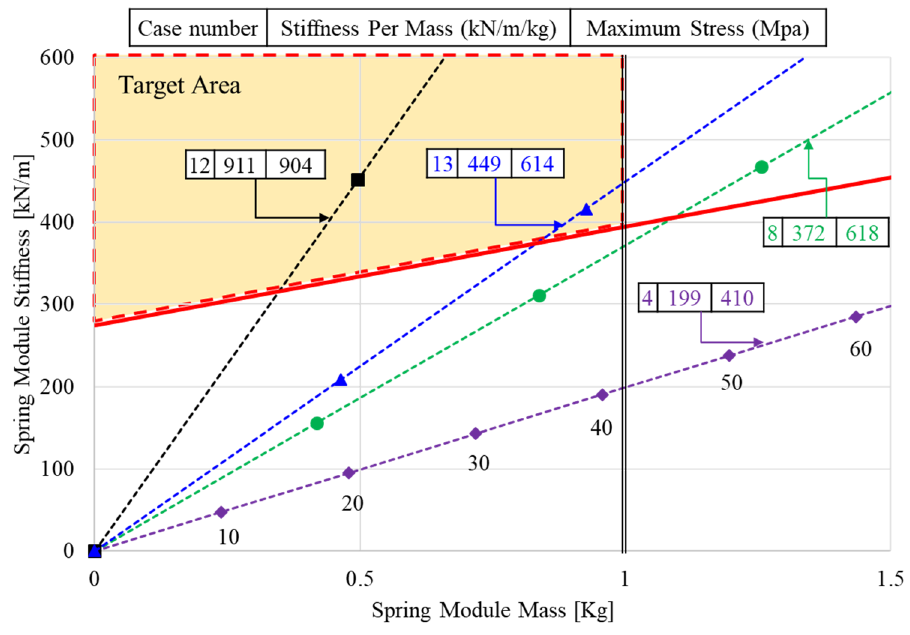
Figure 12. Spring module stiffness versus the spring module mass for cases 4, 8, 12, and 13.